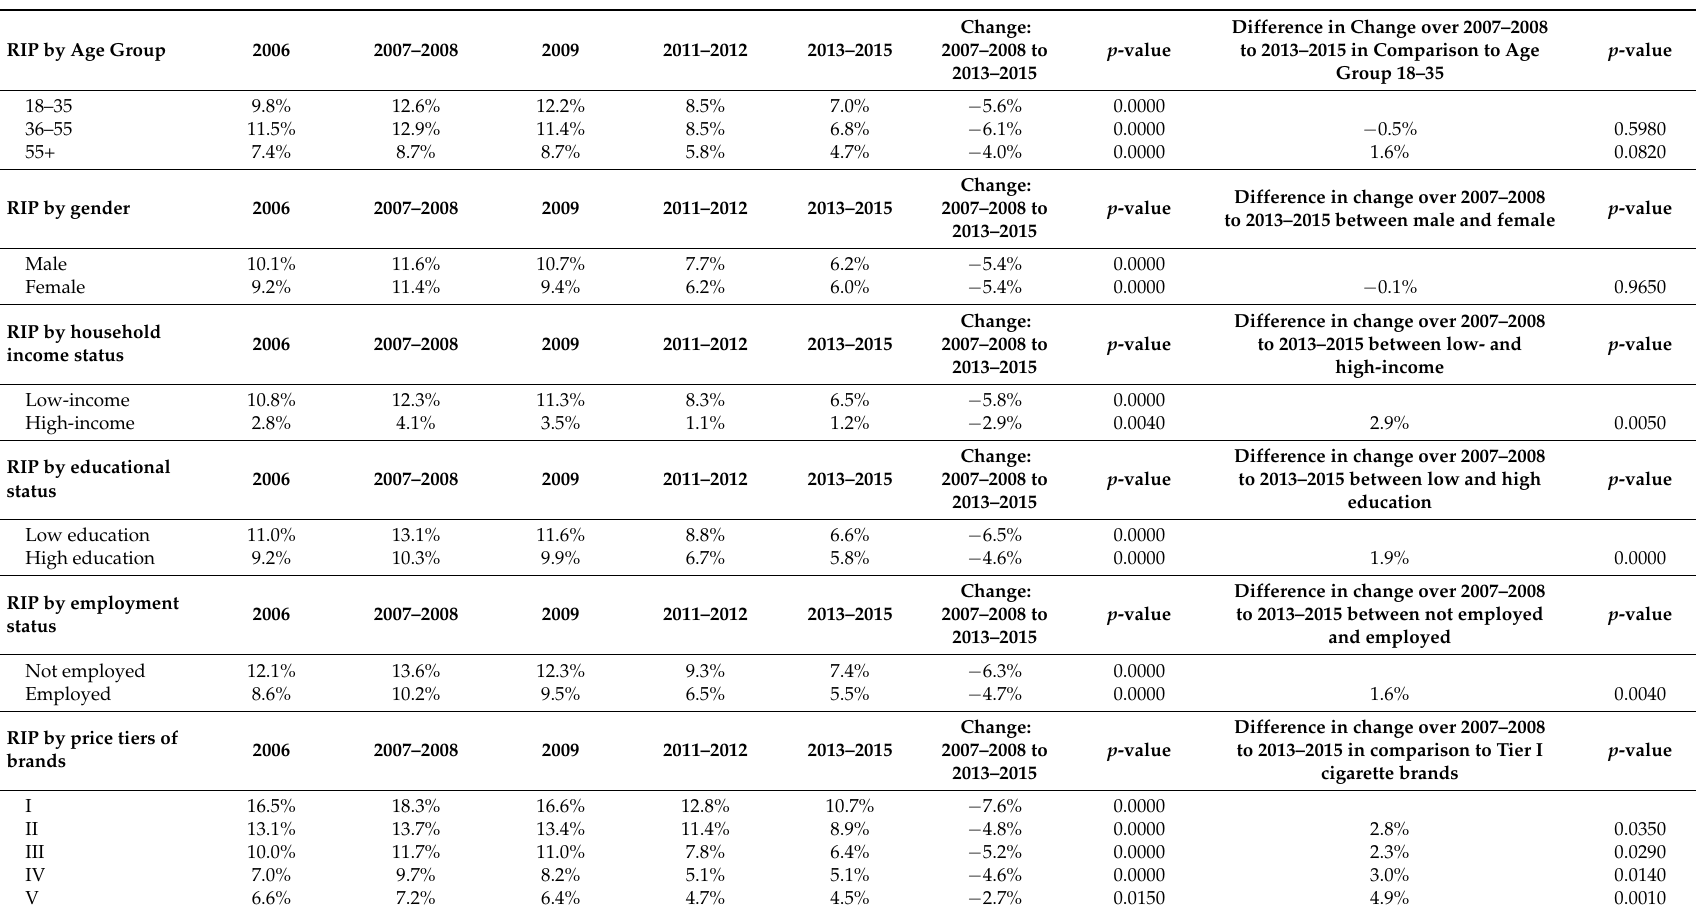
Table 5. Trend in Relative Income Price (RIP) of cigarettes (predicted from GEE estimation) by age, gender, household income status, education, employment